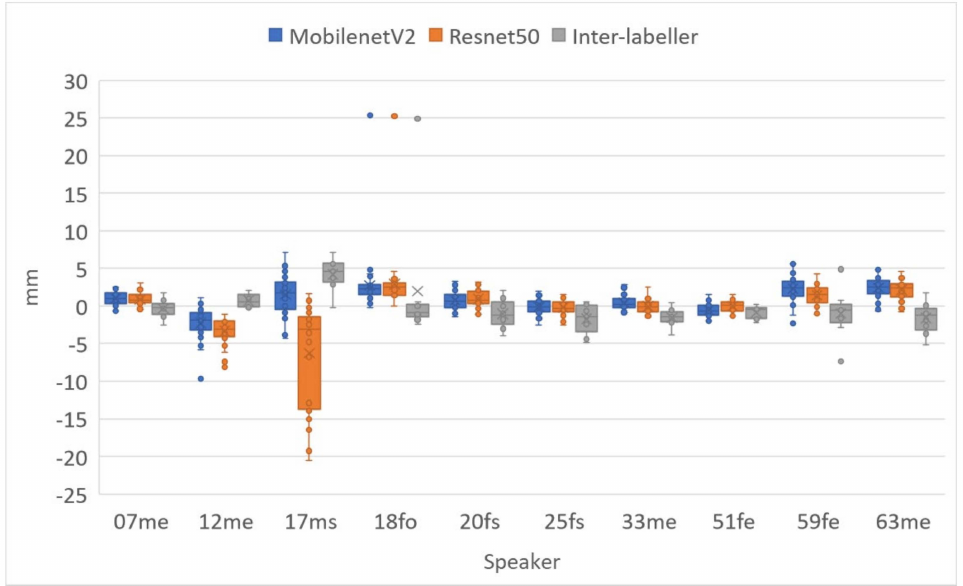
Figure 21. Difference in lip width between hand-labelled randomly selected frames (40 frames for each speaker) and DLC MobileNetV2_1.0, DLC ResNet50, and a second